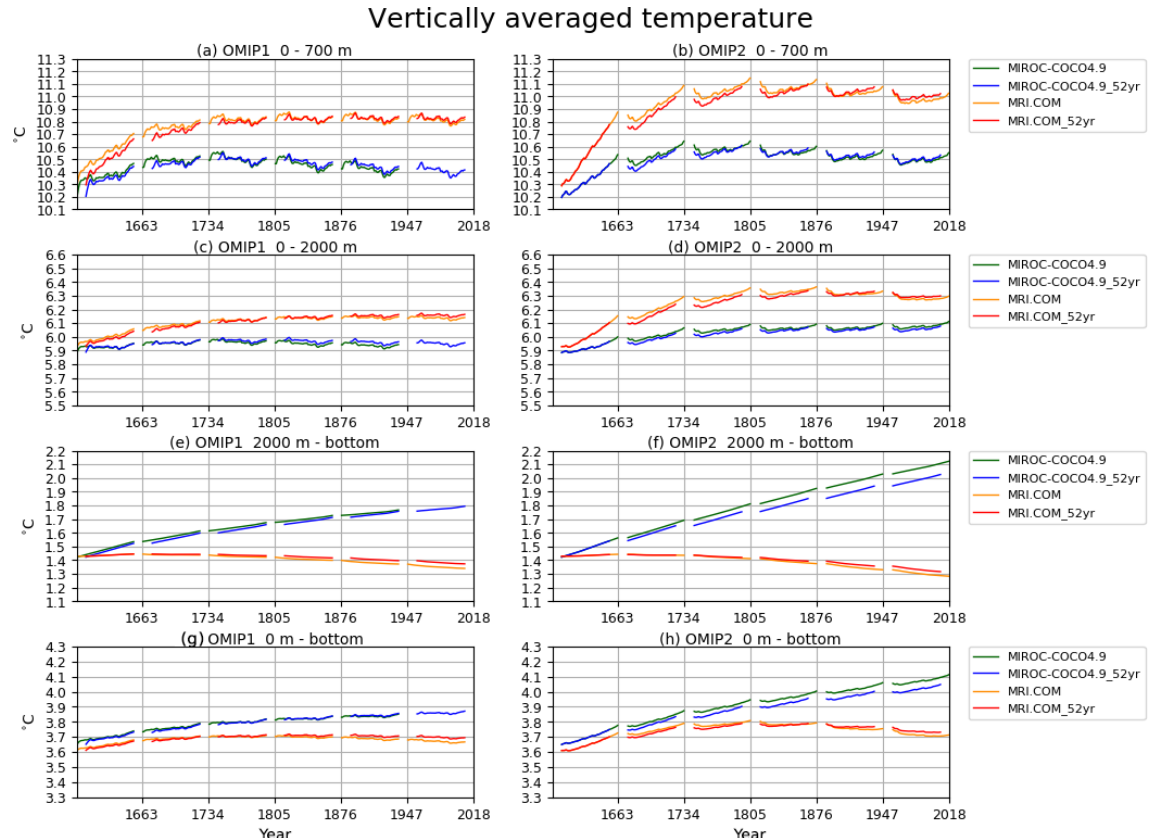
Figure B1. Drift of annual mean, global mean vertically averaged temperatures ( ◦ C) for four depth ranges: (a, b) 0–700m, (c, d) 0–2000m, (e, f) 2000m–bottom, and (g, h) 0m–bottom of two sets of OMIP-1 and OMIP-2 simulations differing in the period used for repeating conducted by two models (MIROC-COCO4.9 and MRI.COM). MIROC-COCO4.9 simulations using the full period (1948–2009 for OMIP- 1 and 1958–2018 for OMIP-2) for repeating (green). MIROC-COCO4.9 simulations using the common period of OMIP-1 and OMIP-2 forcing (1958–2009) (blue). MRI.COM simulations using the full period (orange) and MRI.COM simulations using 1958–2009